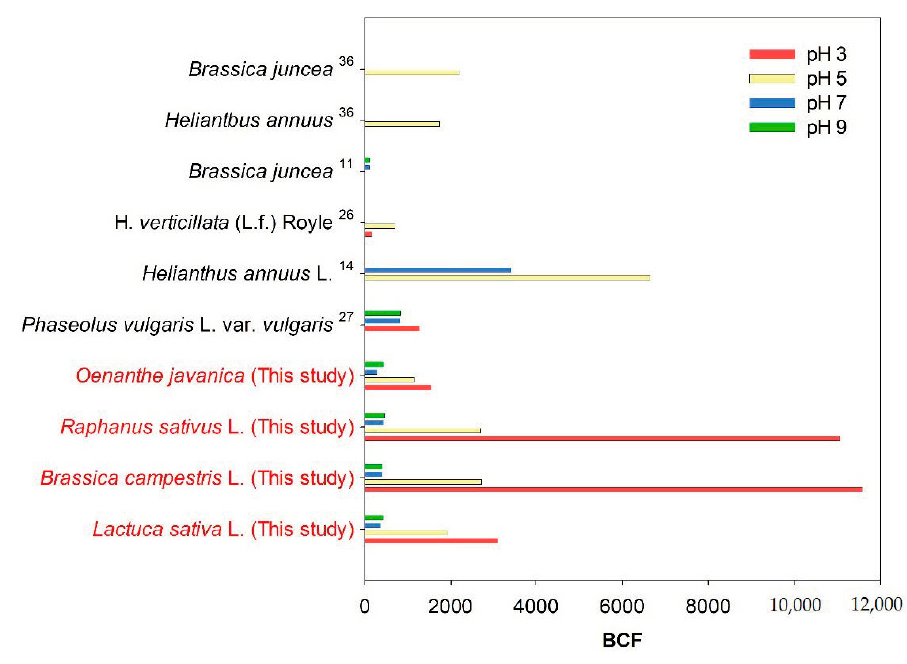
Figure 7. Average uranium BCFs of various plants after accumulation experiments using solutions with different pH values. The BCF values were obtained from previous studies.